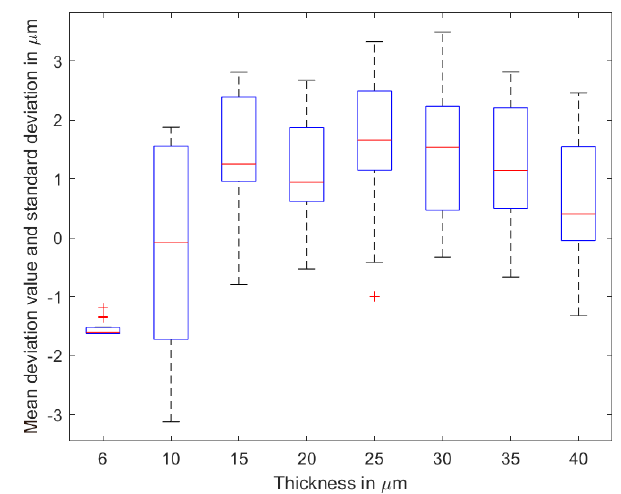
Figure 18. Boxplot of the calculated variation to the true thickness at different layer thicknesses across all